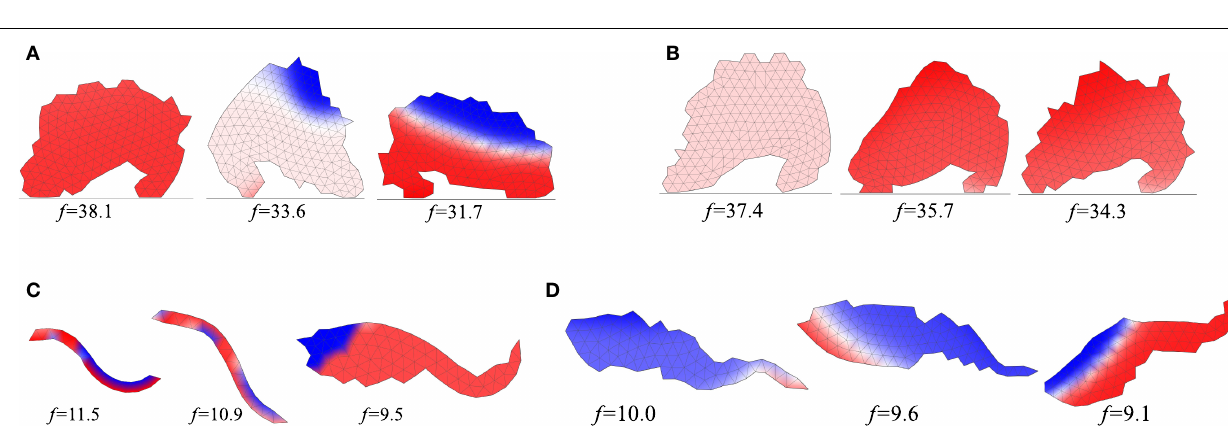
FIGURE 5 | Morphologies of three best swimming (top) and walking individuals (bottom) evolved with GRN-driven gait control and the two search algorithms . Three best individuals for each type of experiment are shown. Colors indicate temporal contraction of a body region (blue) or expansion (red). (A) NEAT search, (B) novelty search, (C) NEAT search, (D) novelty